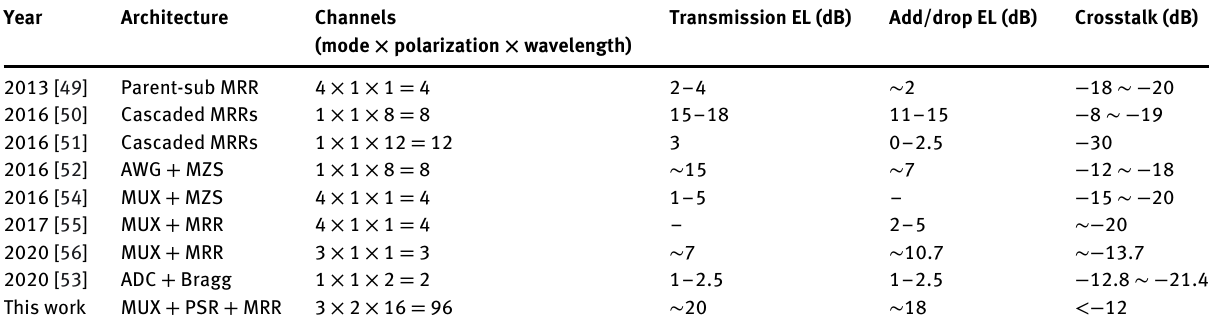
Table 3: Summary of the reported silicon ROADM.